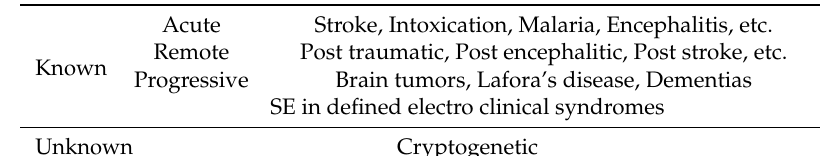
Table 4. Etiologic classification of SE.